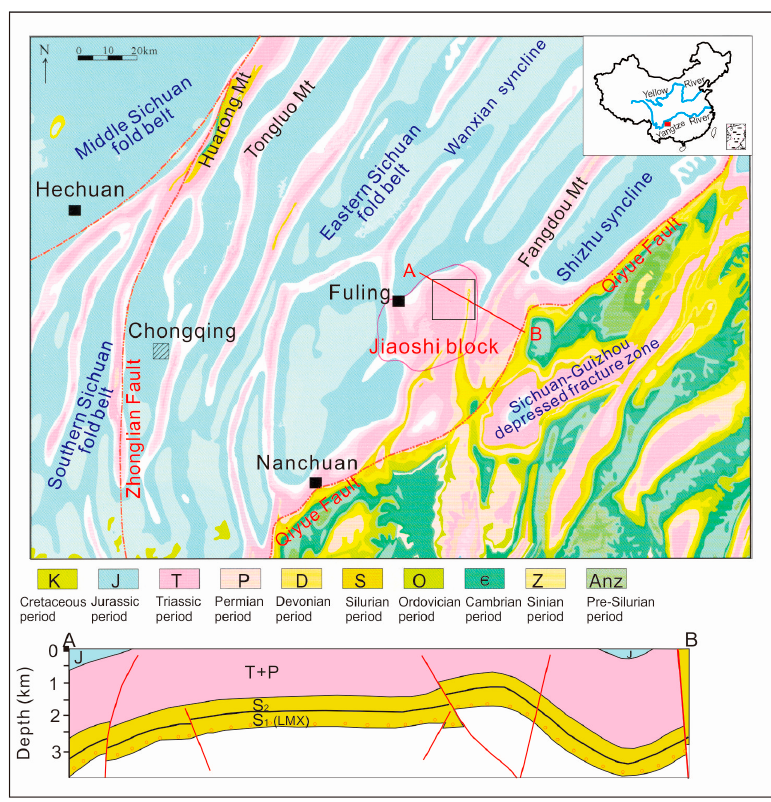
Figure 1. Regional geology and the sketch tectonics of the JSB block, modified from [12,22].